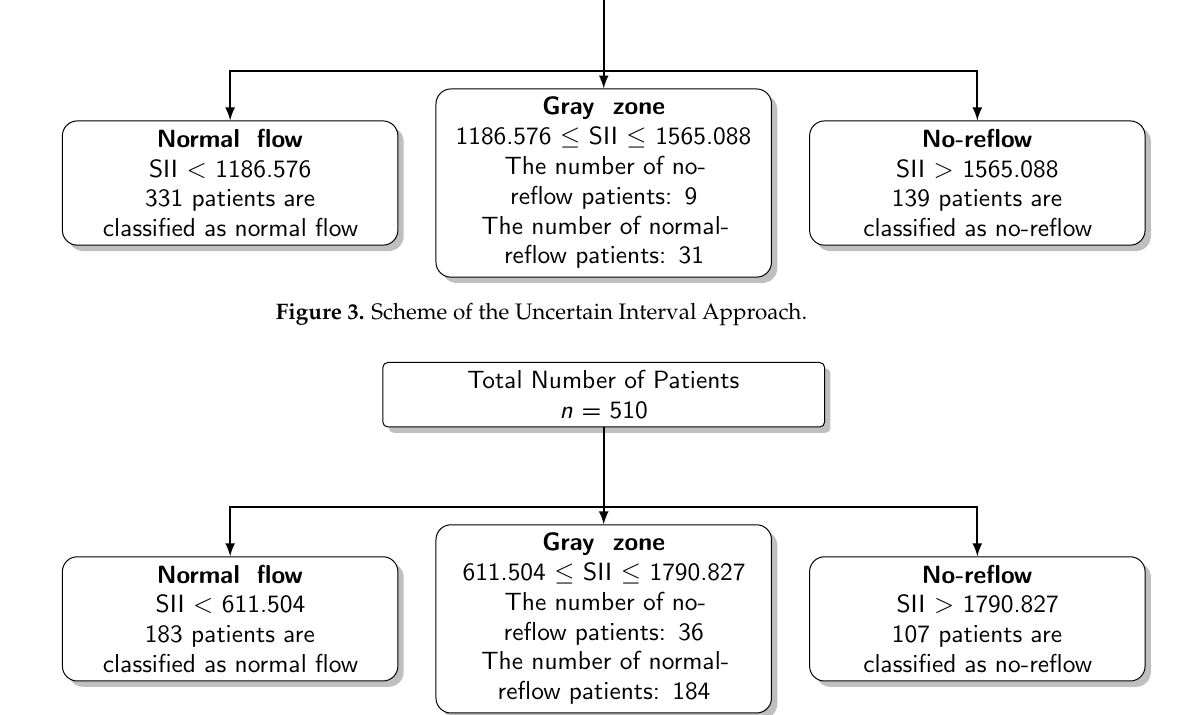
Figure 4. Scheme of the Grey Zone